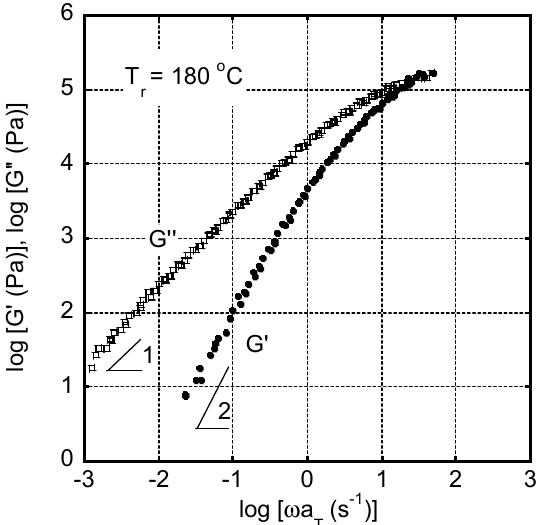
Figure 3. Master curves of shear storage modulus G ′ and loss modulus G ″ as a function of angular frequency ω at the reference temperature T r of 180 °C.